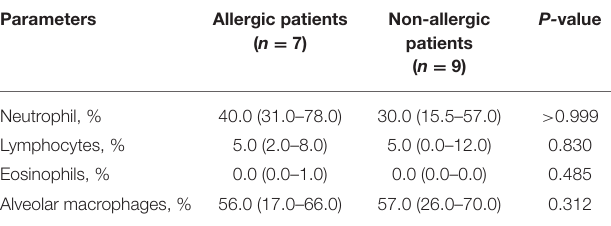
TABLE 2 | BALF cellular content in allergic and non-allergic